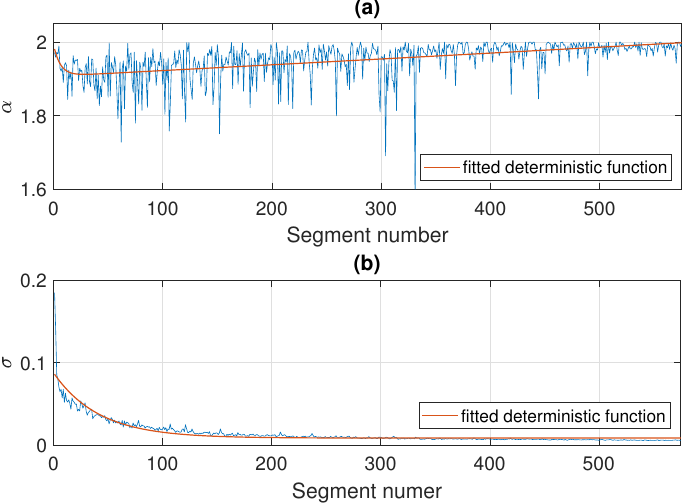
Figure 10. Estimated values of α on panel ( a ) and σ on panel ( b ) in the subsequent segments of length 2500 for Signal 1. Fitted deterministic functions are marked in